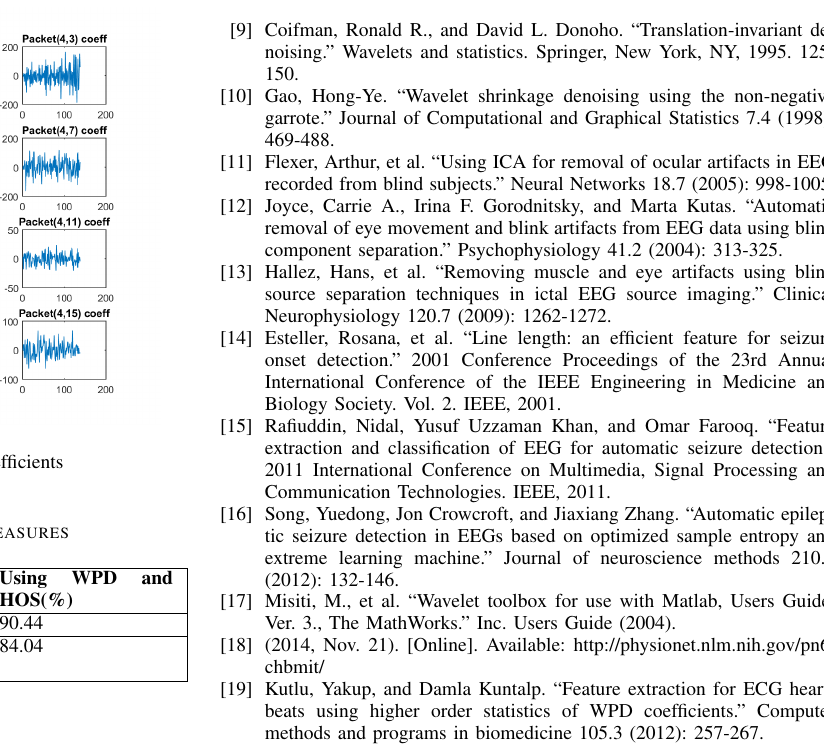
Fig. 7. 2nd level decomposition coefficients